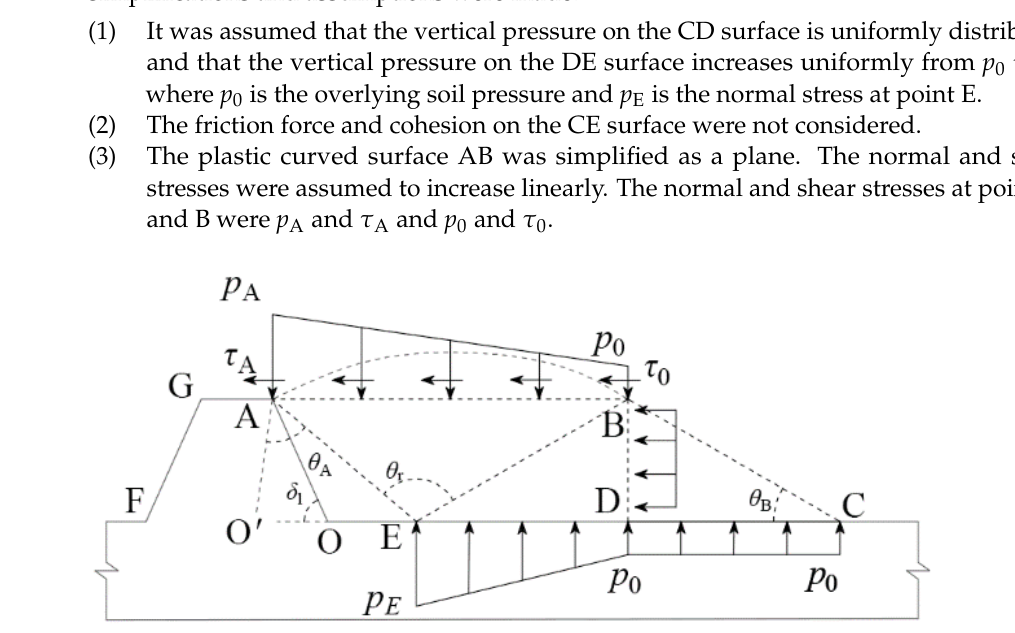
Figure 17. Final failure mode of the soil.